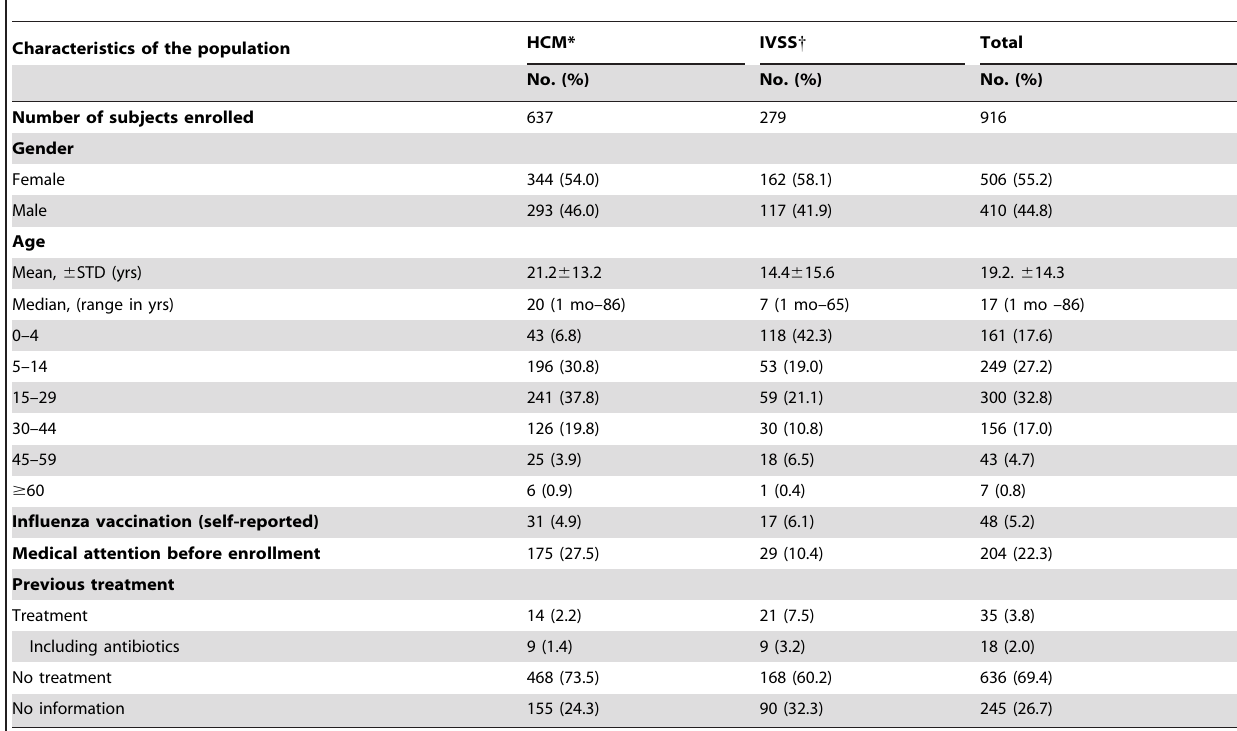
Table 1. Study population recruited by passive surveillance in two hospitals of Maracay, Venezuela: October 2006– December